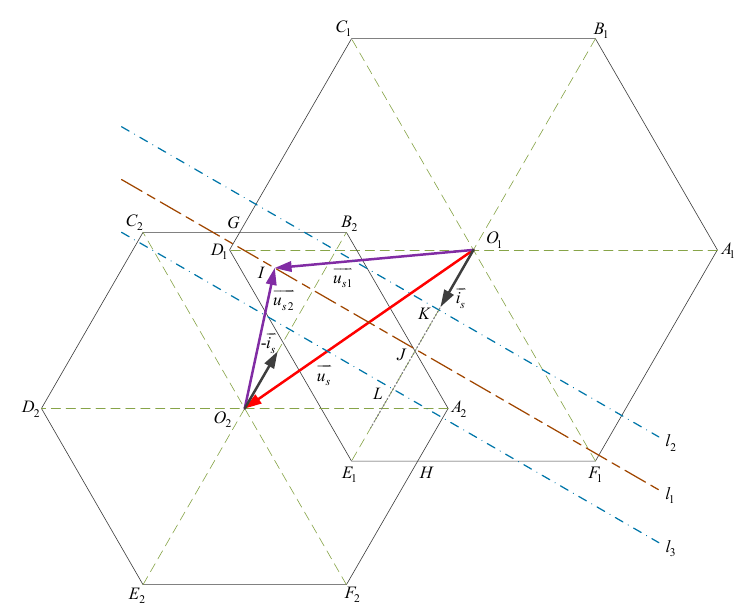
Figure 3. Schematic diagram of voltage vector distribution and power sharing.